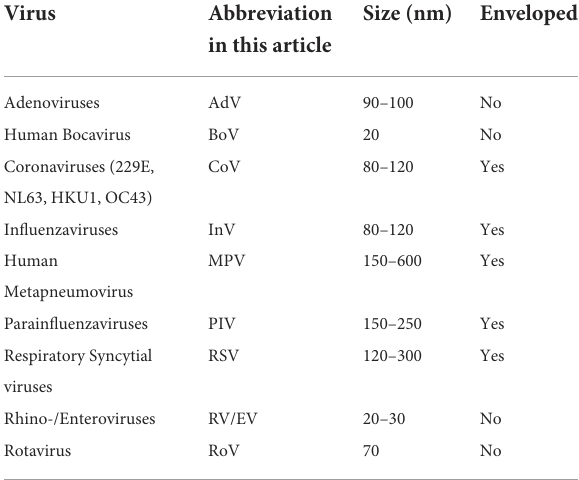
TABLE 1 Overview of viruses considered in this